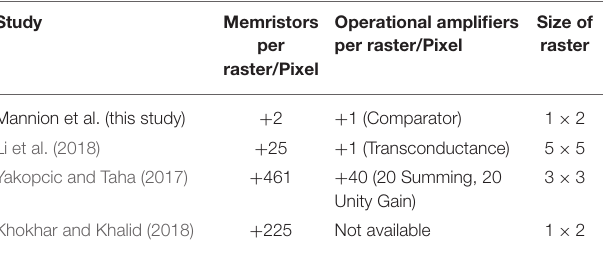
TABLE 1 | Comparison of the increase in component count required for each additional implemented raster.